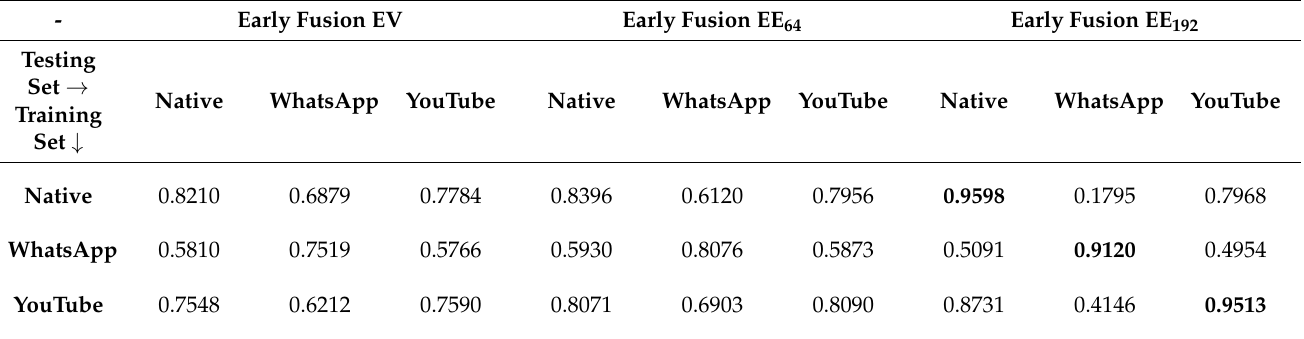
Table 2. Classification accuracy of Early Fusion as a function of training/testing sets. In bold is the highest achieved accuracy in non-cross test scenarios.